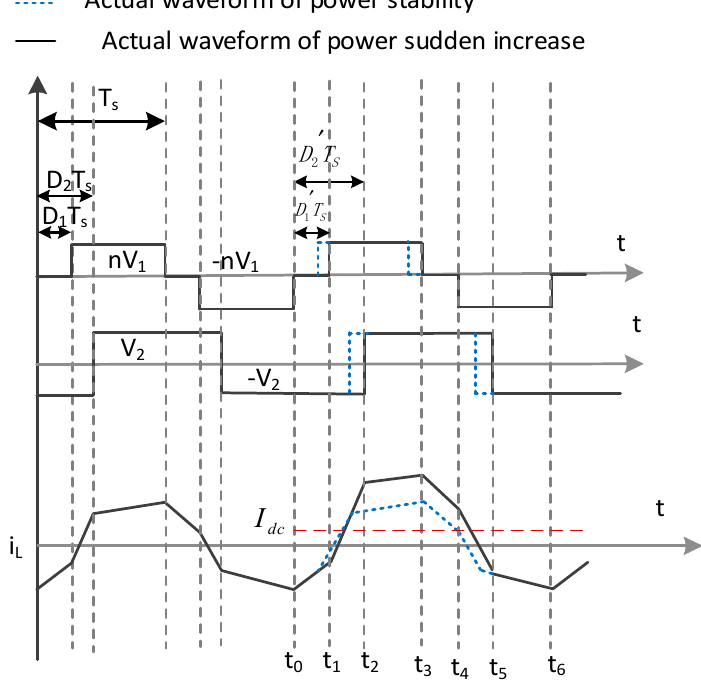
Figure 3. Basic waveforms before and after power changing dynamically.